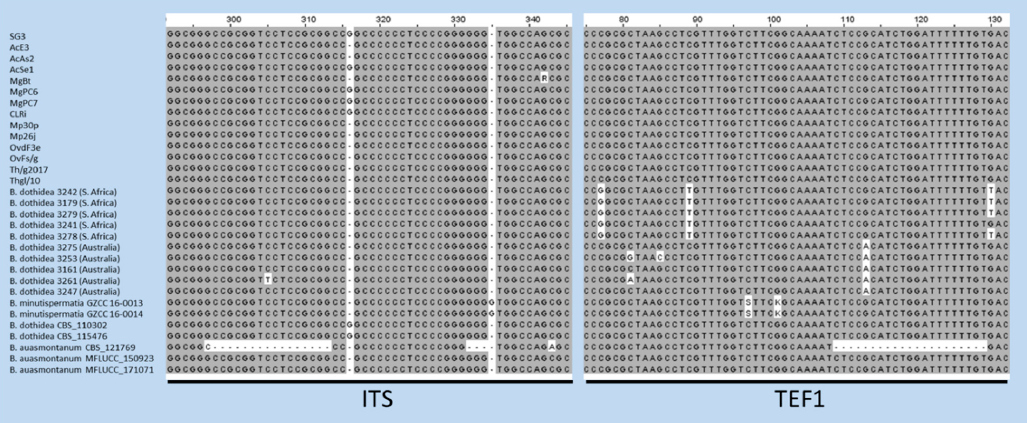
Figure 3. Alignment of ITS and TEF1 sequences of strains of B. dothidea , B. minutispermatia , and B. auasmontanum. Gaps in the sequences of the holotype of the latter species (CBS121769) are evident, along with single nucleotide substitutions in TEF1 sequences of Australian and South African isolates, and the type strains of B. minutispermatia